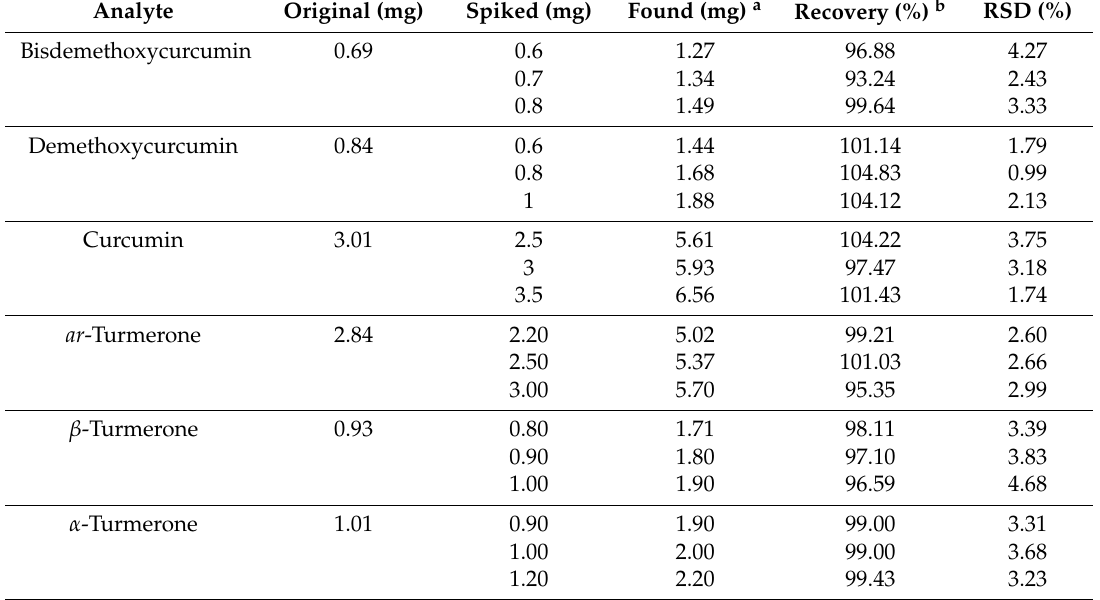
Table 3. Recoveries for the assay of six